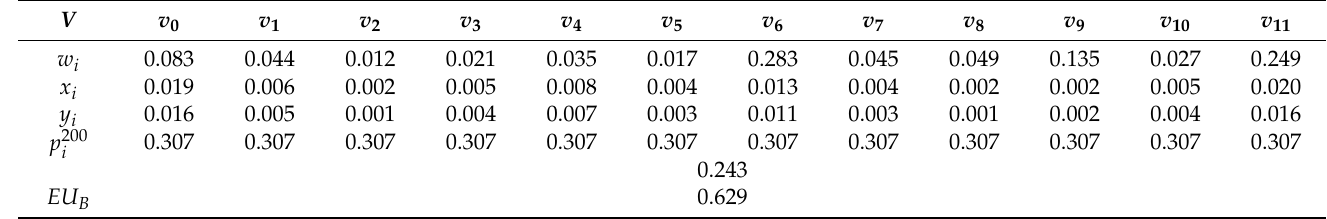
Figure 1. The social network.